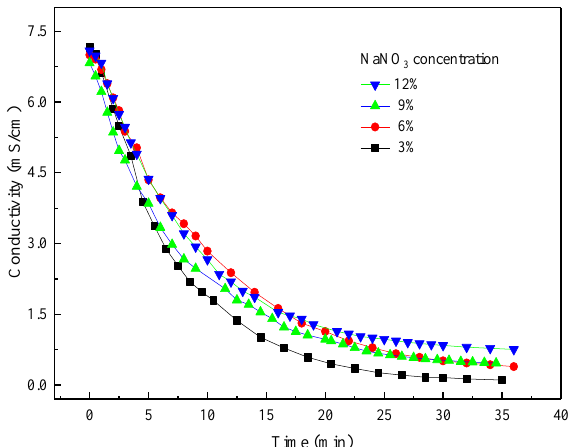
Figure 8. Figure 8. The evolution of conductivities for different electrolyte salt concentrations in the concentrate chamber.